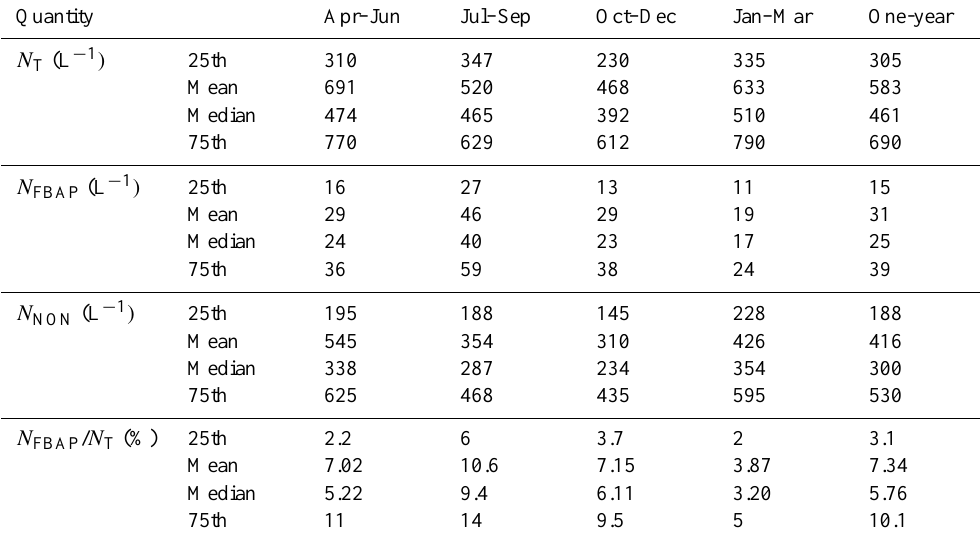
Table 2. Integrated number concentrations for different measurement periods in the case of N T & N FBAP (0.8–16µm): monthly and annual mean and median values between 1 April 2010 and 1 April 2011. Quantity Apr–Jun Jul–Sep